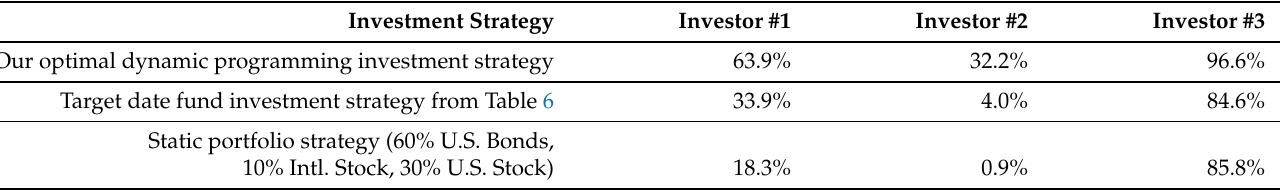
Table 8. The effect of the investment strategy on the optimal probability of solvency when the investor is projected to die at age 90. As before, in all cases we determine and apply the optimal tax